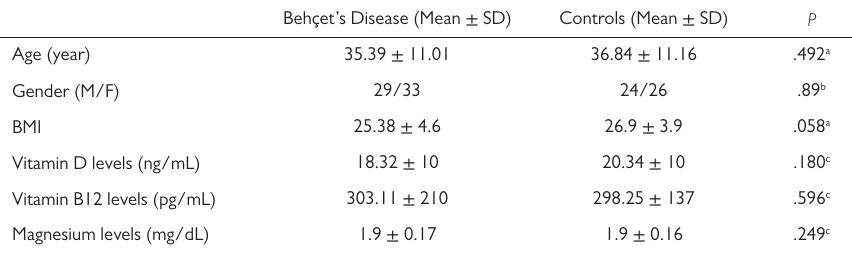
Table 1. Demographic and Laboratory Parameters of Participants